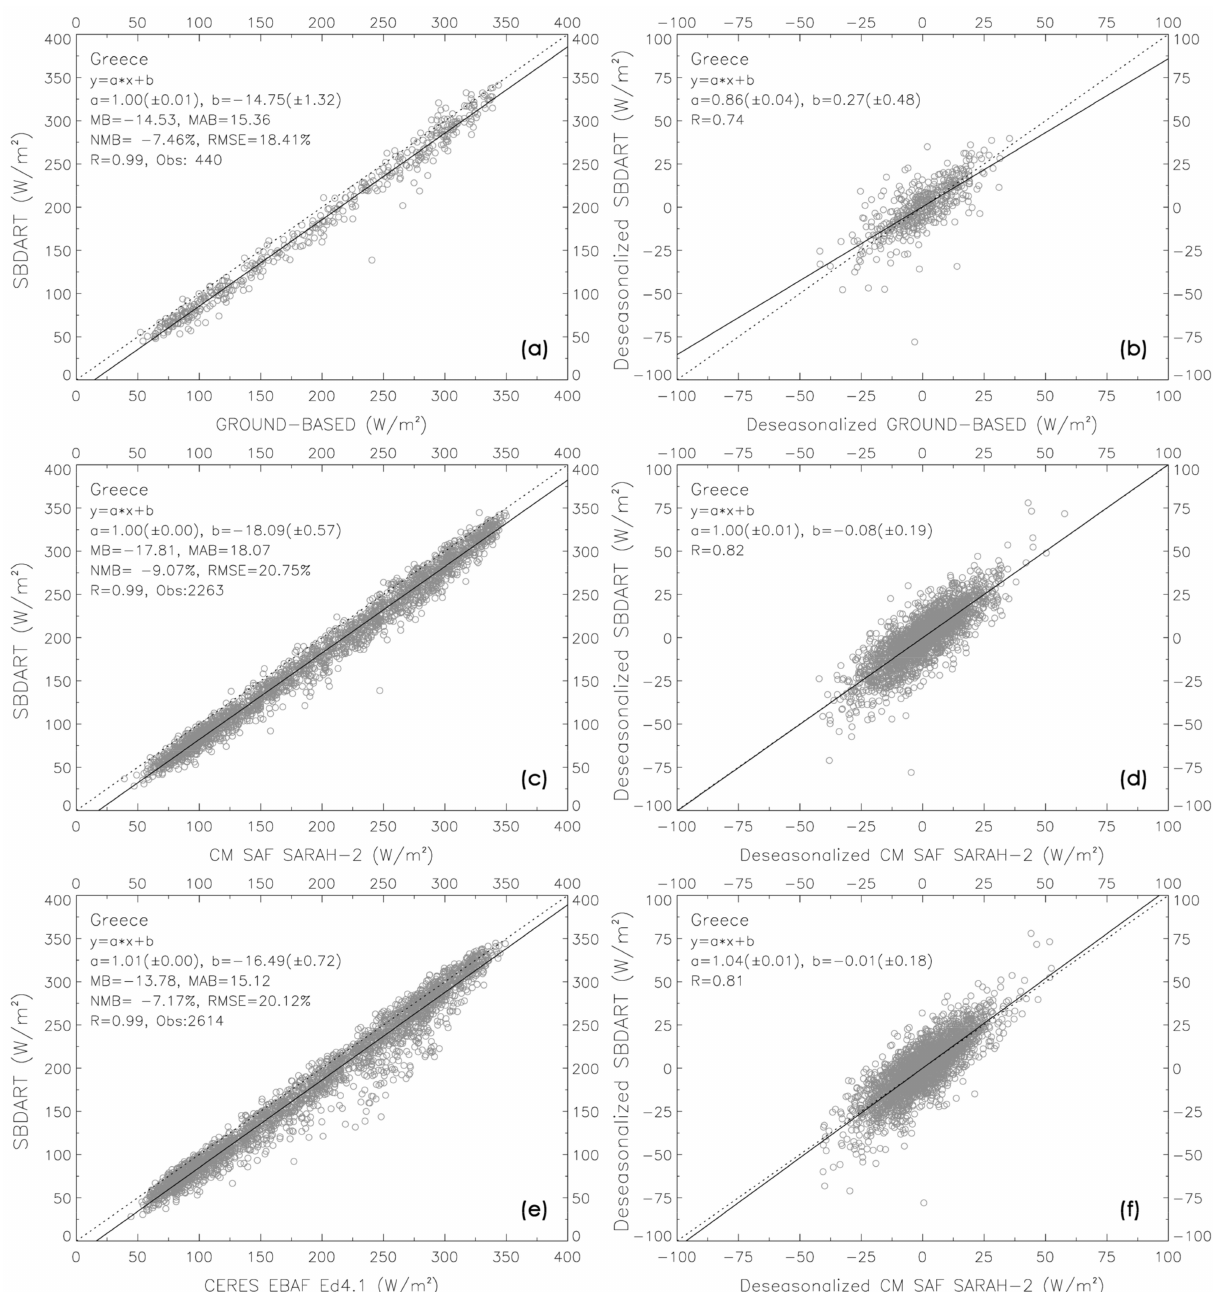
Figure 3. Scatterplot of monthly mean SSR data produced in this work based on SBDART and ( a ) ground-based SSR observations from Thessaloniki, Athens, and HCMR; ( c ) CM SAF SARAH-2.1 SSR data from all the 16 locations that are studied here; and ( d ) CERES EBAF edition 4.1 SSR data from all the 16 locations that are studied here. The grey open circles represent the collocation points, the solid line is the regression line and the dashed line is the 1:1 line. The regression line (slope and offset with the corresponding ± 1 σ ) and the correlation coefficient R, the MB, MAB, NMB, RMSE and the number of collocation points are also given on the plots. The ( b , d , f ) plots are the same as the ( a , c , e ) plots, respectively, but for deseasonalized